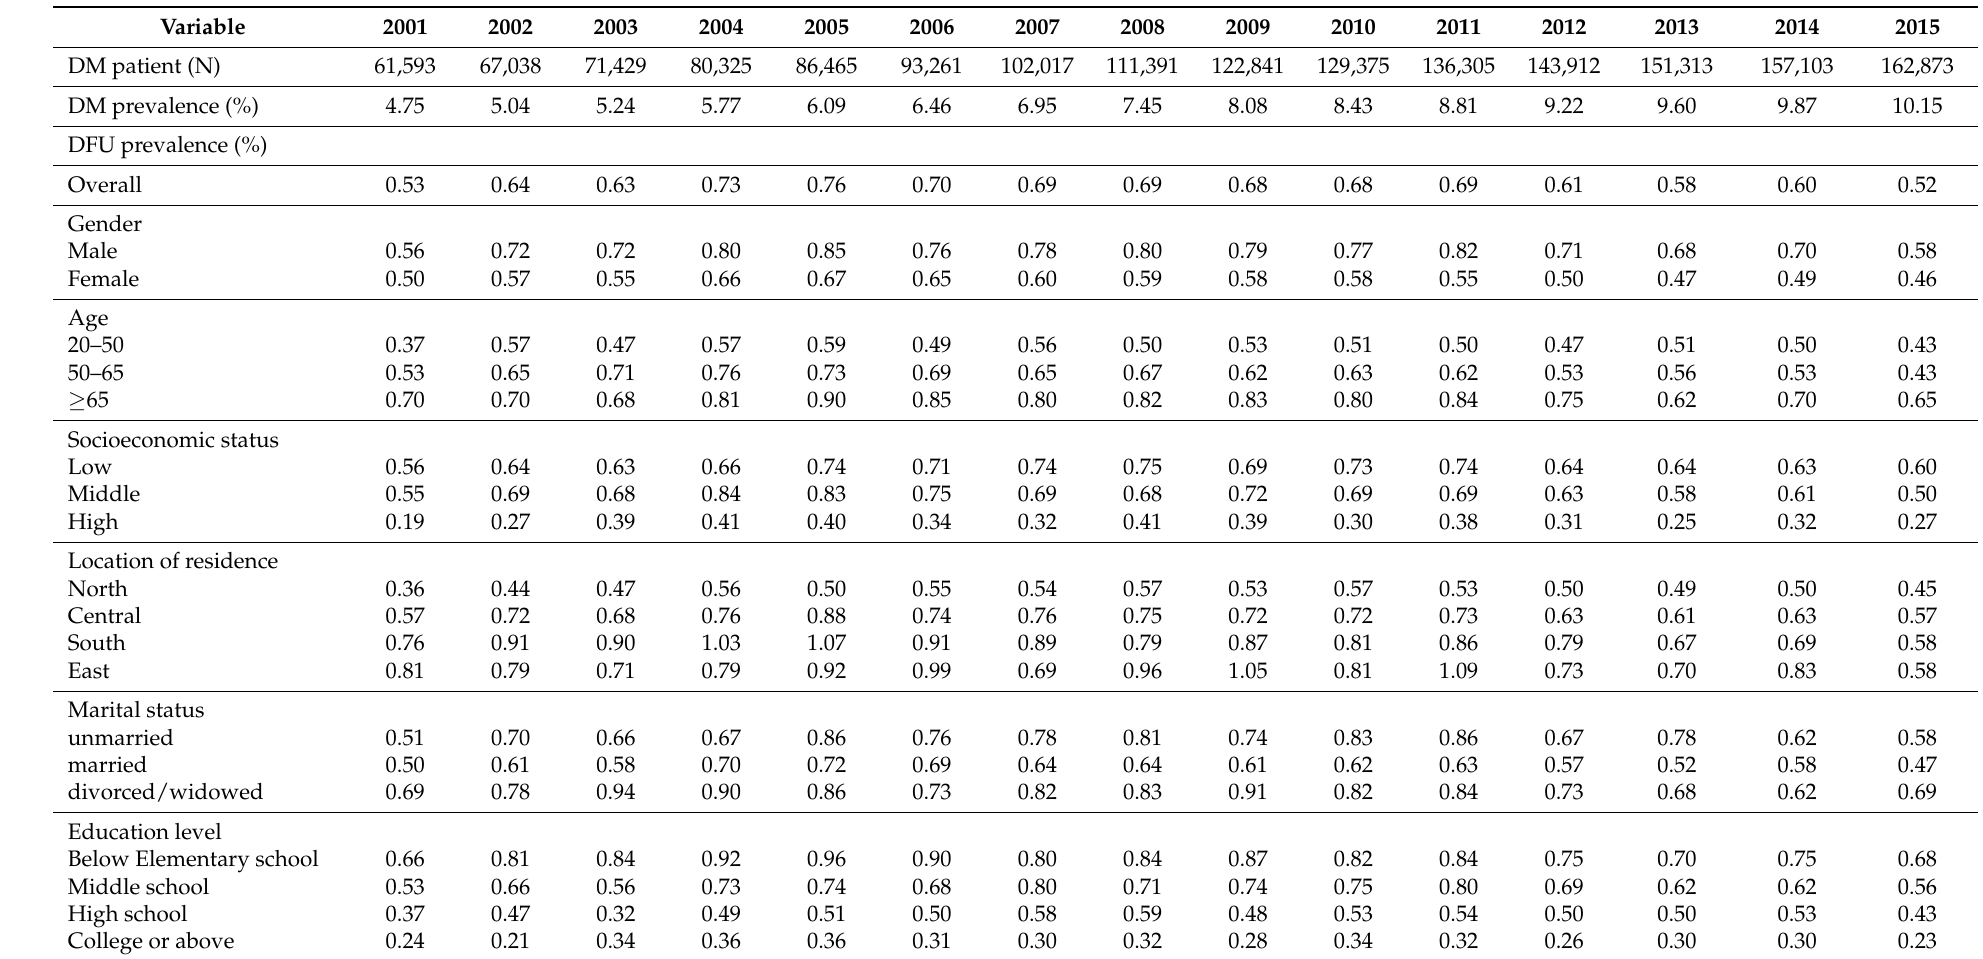
Table 2. DFU prevalence during